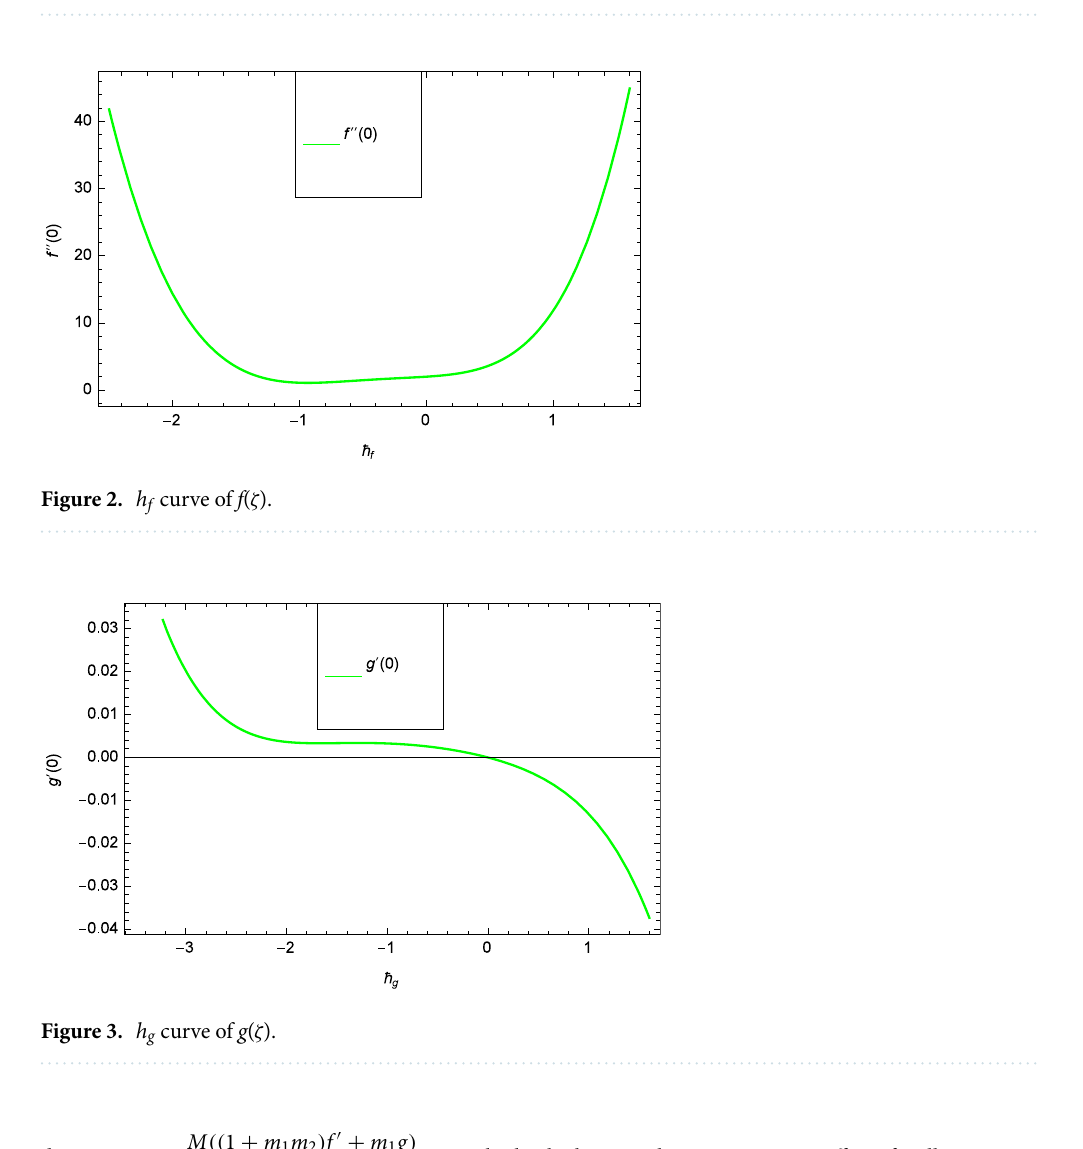
Table 3. Comparison of f ′′ (0) values for accretion rate and the parameter γ .